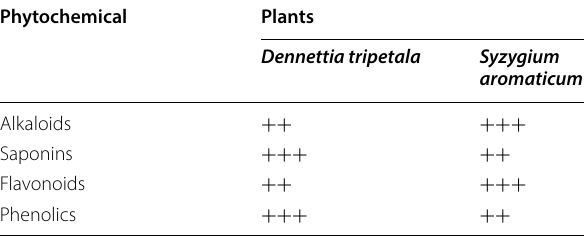
Table 2 Qualitative phytochemical composition of plant